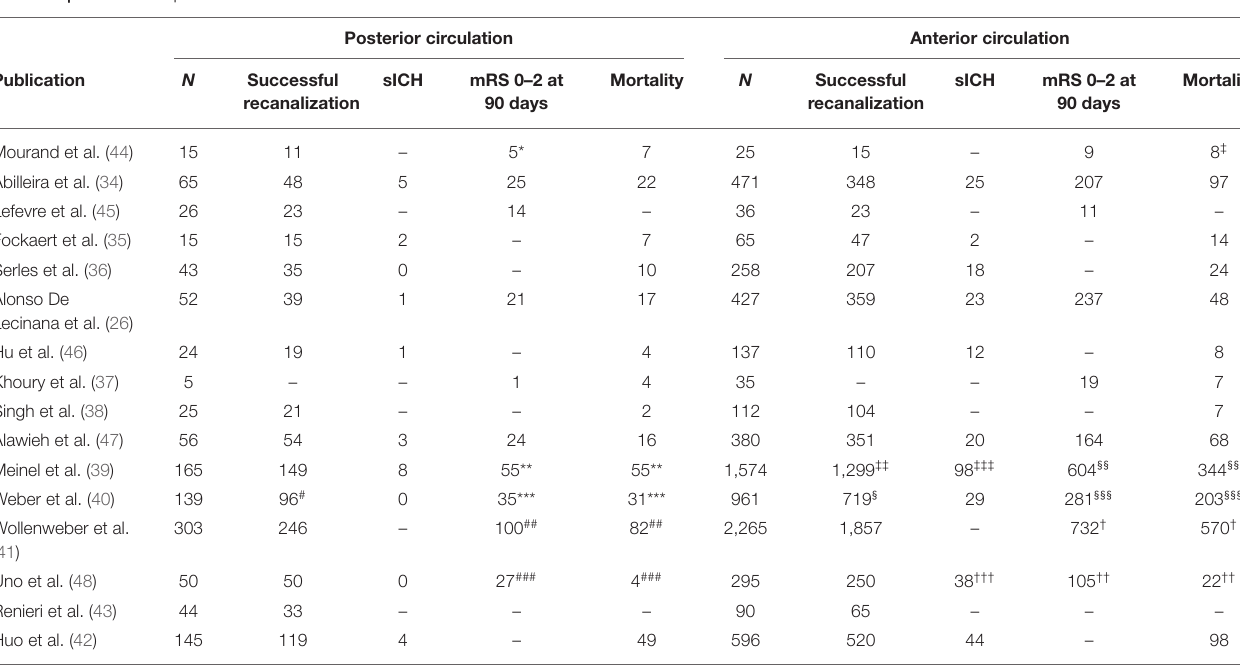
TABLE 2 | Outcomes reported in included